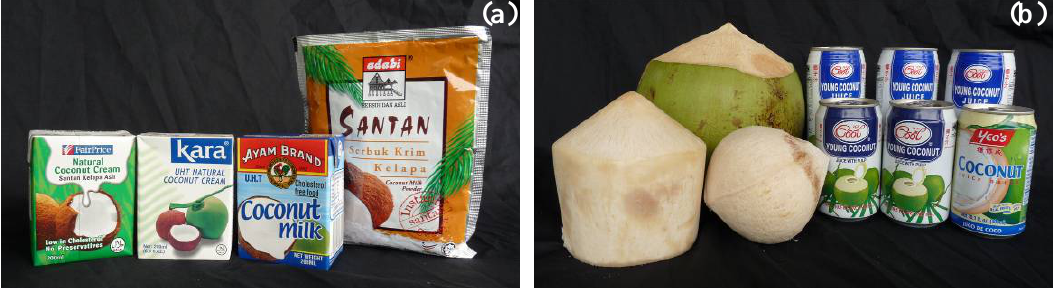
milk powder; (b) canned coconut water/juice and trimmed young